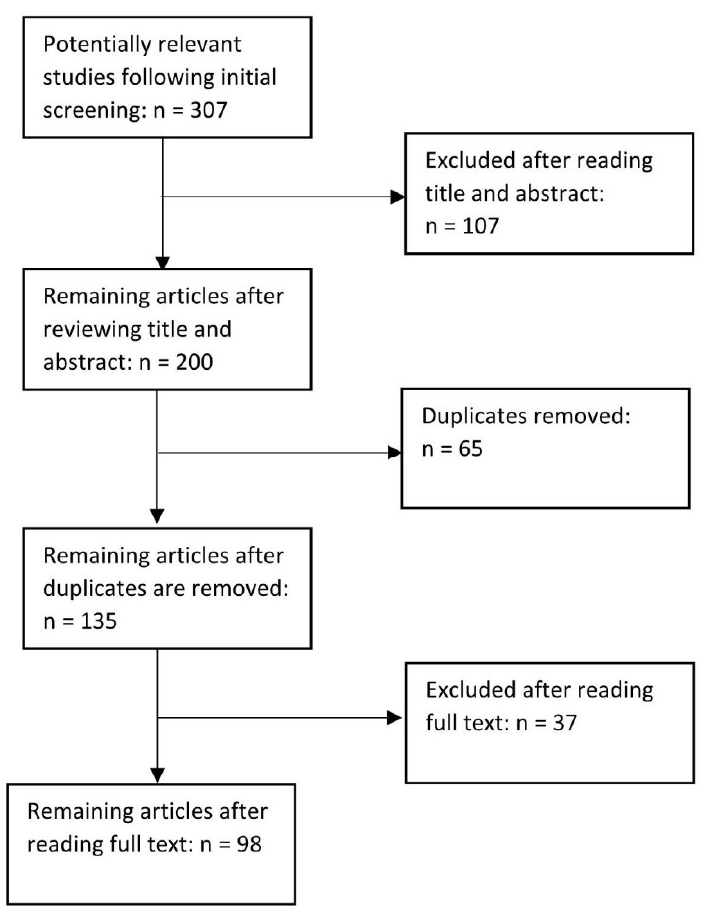
Figure 2. Final number of articles included after the review for relevance and duplicates.